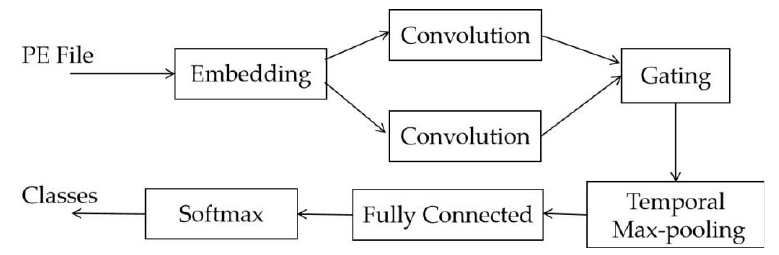
Figure 2. Structure of MalConv.